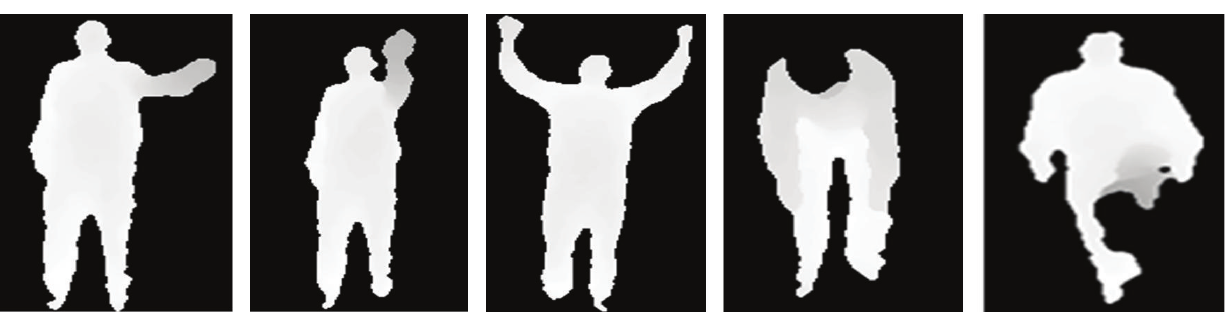
Figure 12: Examples of depth actions images used in MSRAction3D dataset.